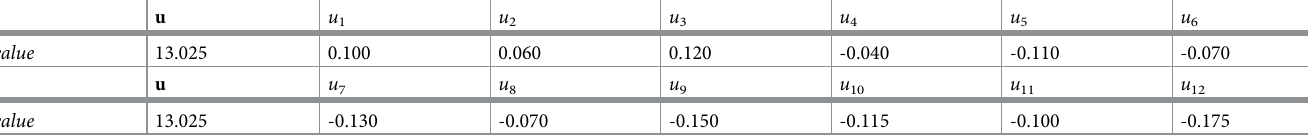
Table 1. Compensation amount of pixel moving speed in X direction between different images in swinging strip.